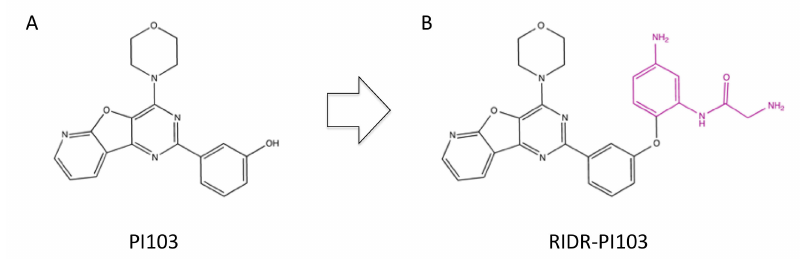
Figure 9. Structure of PI103 ( A ) and RIDR-PI103 ( B ). The phenyl acetamide group, which is removed upon stimulation by reactive oxygen species, is highlighted in violet.